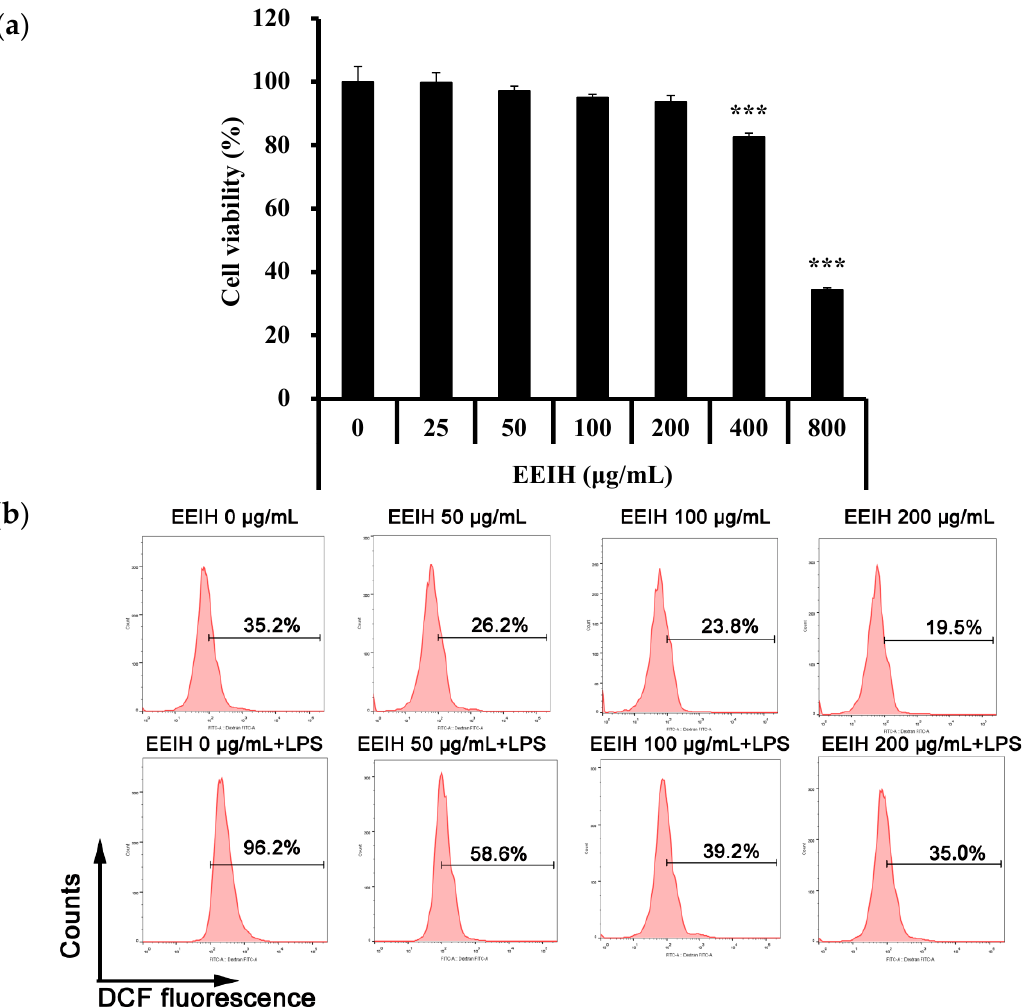
Figure 3. Effect of EEIH on viability ( a ) and reactive oxygen species (ROS) production ( b ) of RAW264.7 cells. The values are presented as mean ± SD ( n = 3). Significant differences with control cells were designated as *** p < 0.001. The figure shown is representative of three independent experiments.